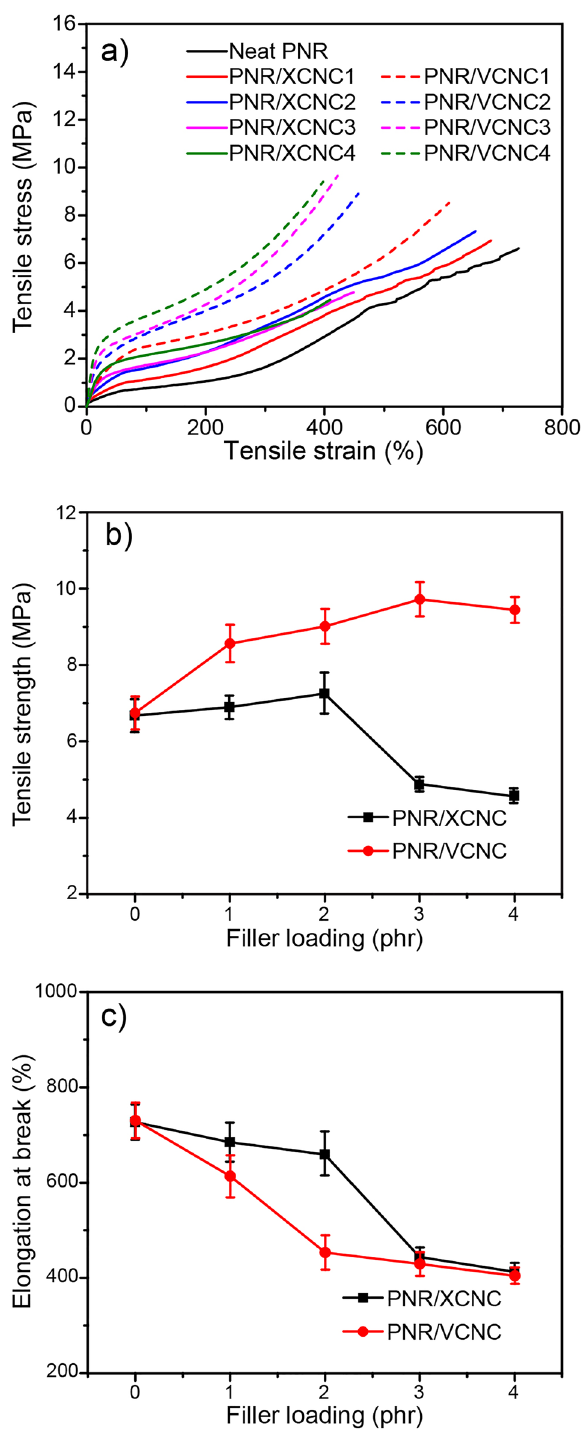
Figure 14. Tensile test results of the biocomposites; ( a ) stress–strain curves, ( b ) tensile strength, and ( c ) elongation at